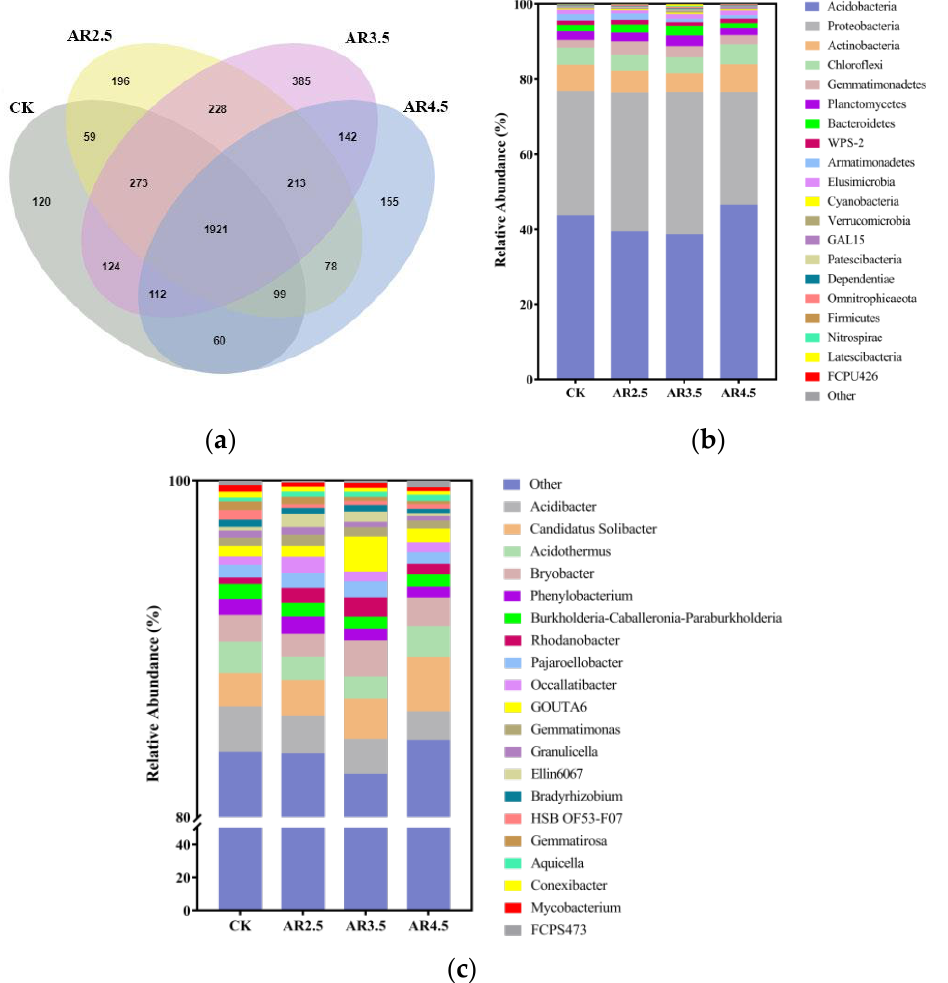
Figure 2. Venn of bacterial OTUs ( a ), community composition at the phyla of soil bacteria ( b ), and community composition at the genus of soil bacteria ( c ) of all treatments. Black dots exist in the set, black dots with a line between them represent intersections, and gray dots do not exist in the intersections. CK: control without acid rain; AR2.5: Acid rain at pH 2.5; AR3.5: Acid rain at pH 3.5; AR4.5: Acid rain at pH 4.5.